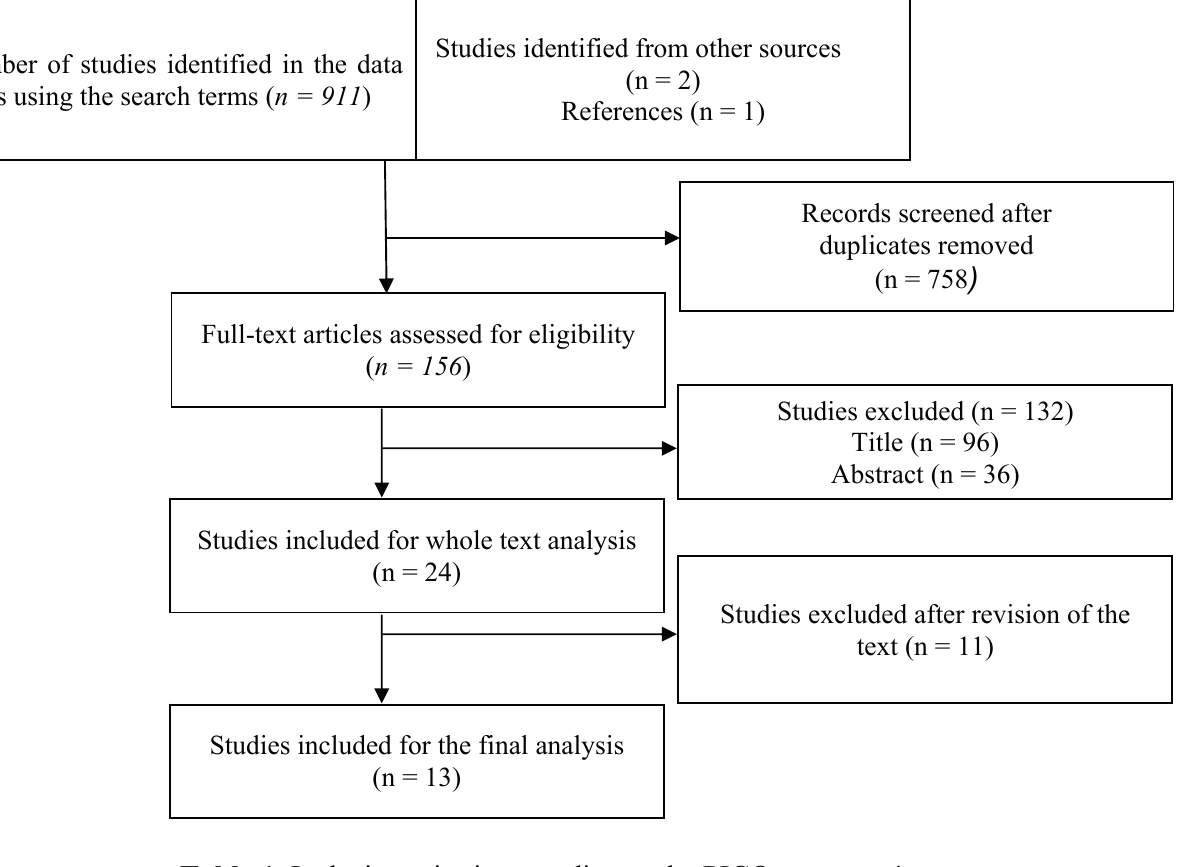
Figure 1. Flow-chart of studies included in the systematic review.